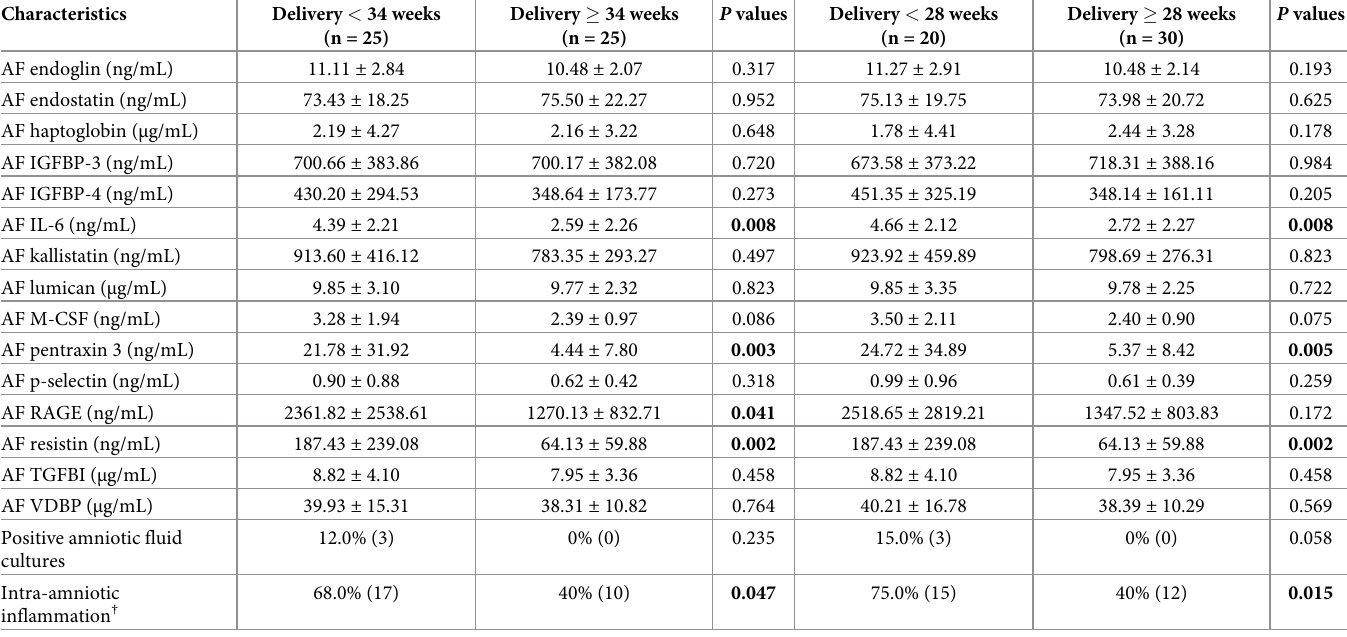
AF, amniotic fluid; IGFBP, insulin-like growth factor-binding protein; IL, interleukin; M-CSF, macrophage colony-stimulating factor; RAGE, receptor for advanced glycation end products; TGFBI, transforming growth factor beta-induced; VDBP, vitamin D-binding protein. Values are shown as the mean ± standard deviation. † Intra-amniotic inflammation was defined as AF IL-6 � 2.6